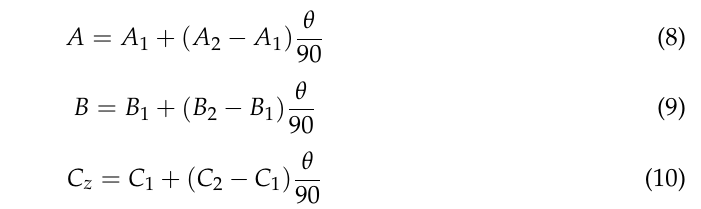
Figure 5. Diagram of the cutting process.